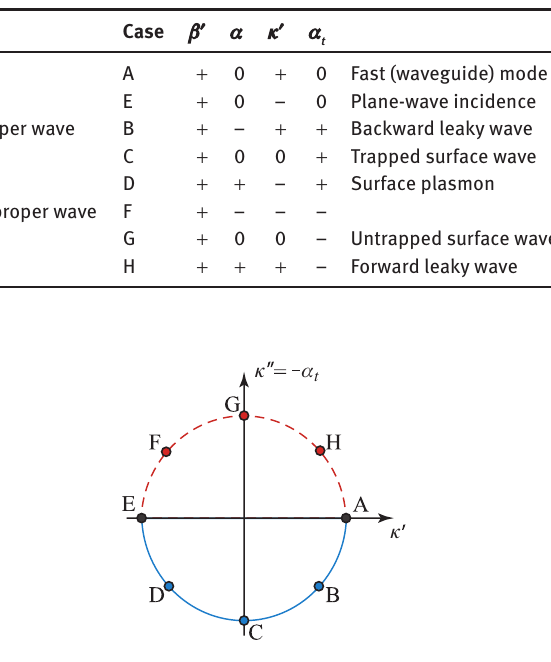
and presented in [8] in the forms of a table (Table A1) and a circle is plotted on the complex κ ′ − κ ″ plane (Figure A1), where the waves whose transverse propagation constant κ belongs to the lower half-plane are attributed to the proper waves; otherwise, they are improper waves.